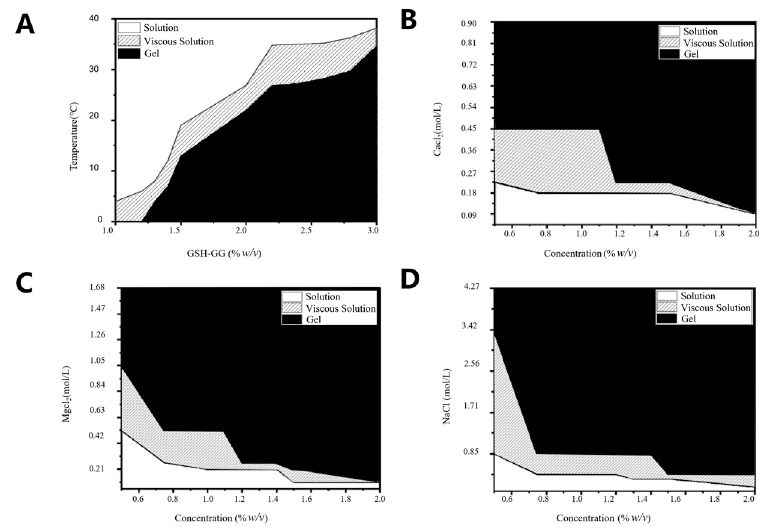
Figure 2. Effect of temperature ( A ) and cations (( B ) for Ca 2+ , ( C ) for Mg 2+, and ( D ) for Na + ) on gelling gelling behavior of behavior of GSH-GG.